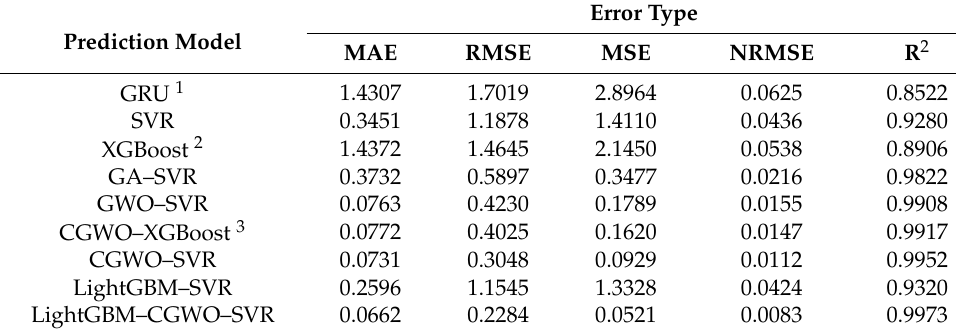
Table 4. Experimental results of different prediction models.